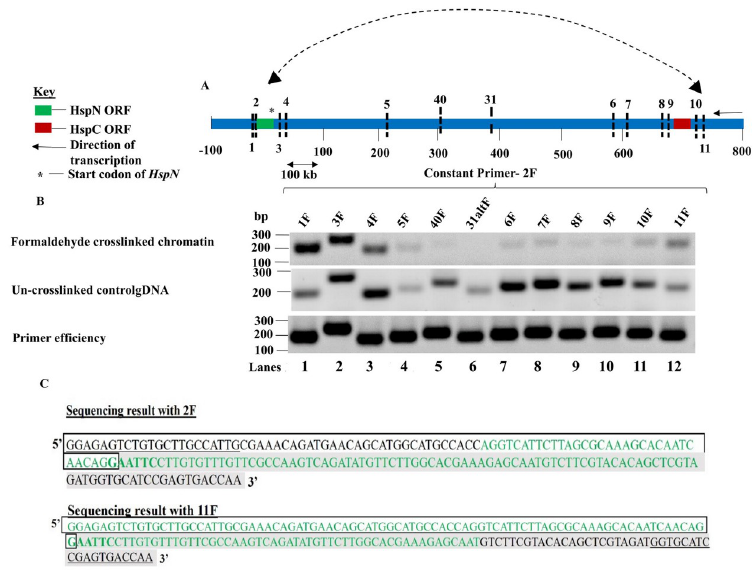
Fig 2. HspN and HspC ORFs physically interact in the nucleus. A) Schematic representation of the relative positions of different EcoR1 loci in the vicinity and in between HspN and HspC ORFs on chromosome 5. B) First panel shows the PCR products obtained with constant primer 2F with other forward primers designed across the different loci in vicinity and in between HspN and HspC ORFs chosen for this study. Loci 1 and 3 which are in proximity to locus 2 show intense bands of corresponding sizes. As the distance from locus 2 increases, the PCR amplicons fade out and the PCR signal then starts picking up from locus 6 gradually; increasing significantly at locus 11 confirming physical proximity and interaction between loci 2 and loci 11 which are proximal to HspN and HspC ORFs respectively. Second panel shows the PCR products obtained with constant 2F primer with other forward primers corresponding to the different chosen loci for randomly ligated control gDNA. Third panel shows PCR amplicons of equal intensities with 2F constant primer and other forward primers indicating equal primer efficiencies. C) The enriched hybrid formed from locus 2 and locus 11 (Fig 2B, panel 1-lane 12) was excised and subjected to Sanger’s DNA sequencing with primers; 2F and 11F. Sequencing result with 2F as the primer could detect the presence of sequences from locus 2 and locus 11 which confirms the presence of this hybrid in the enriched band. Similarly, sequencing result with 11F as the primer could detect the presence of sequences from locus 11 and locus 2 which confirms the presence of the hybrid in the enriched